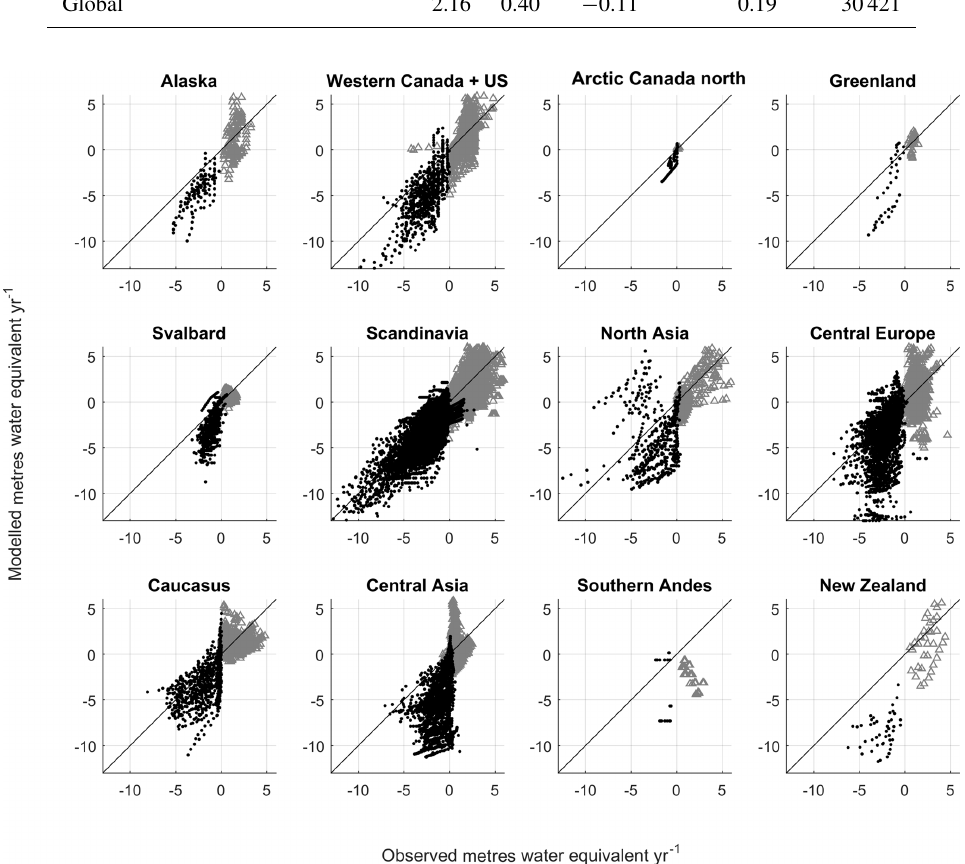
Figure 4. Comparison between modelled and observed elevation-band specific mass balance for winter (grey triangles) and summer (black dots). The modelled mass balance is calculated using the tuned regional parameters from the calibration